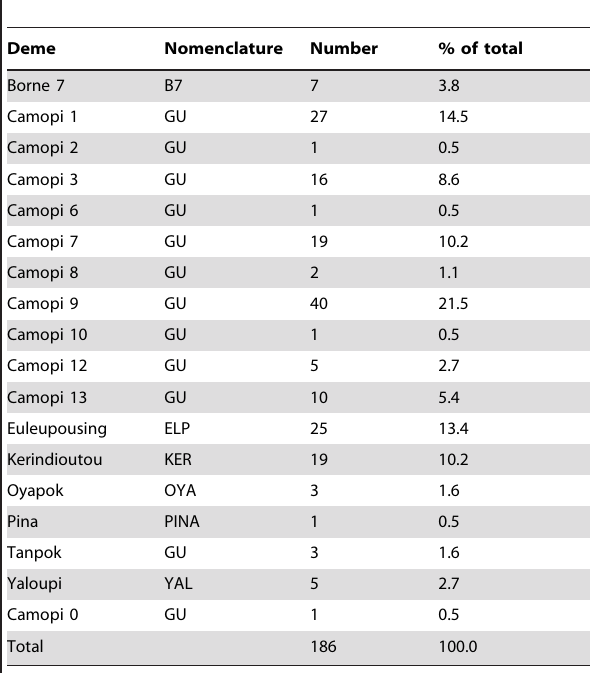
Table 1. Distribution by deme of the 186 ‘‘Guiana’’ clones